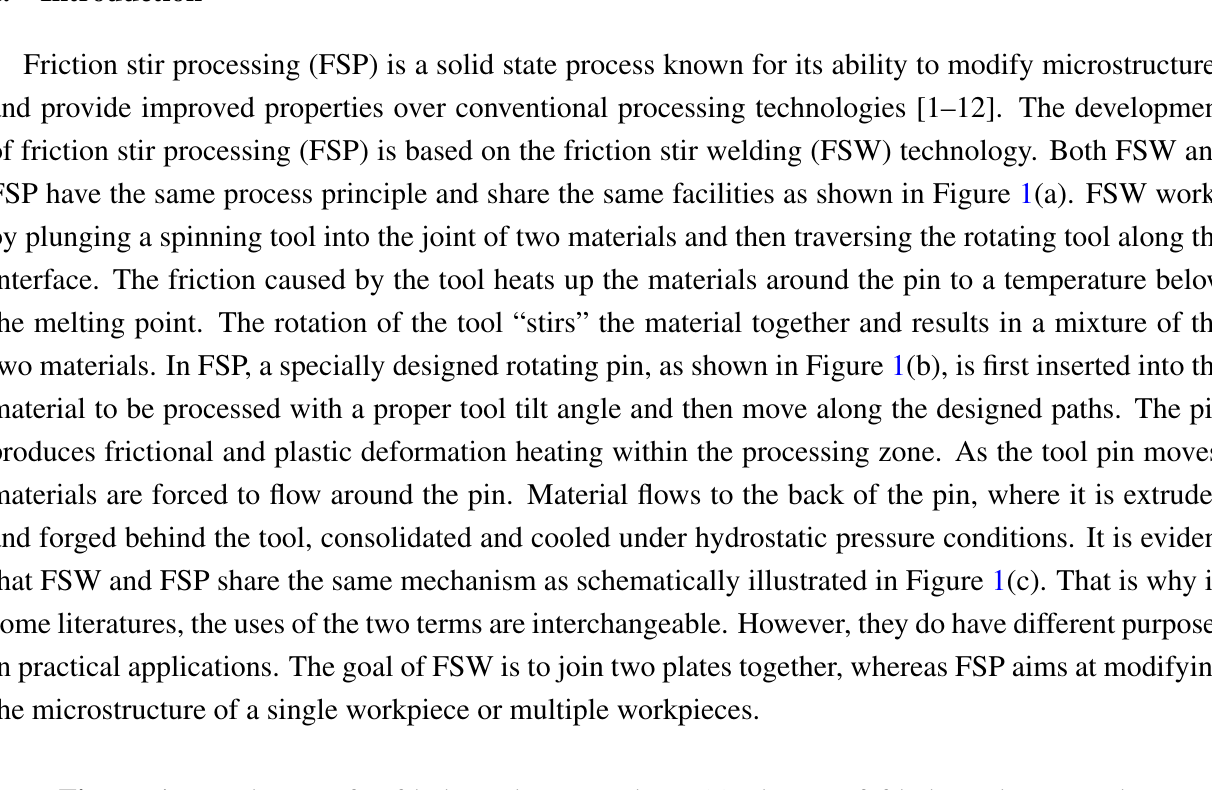
Figure 1 . Equipment for friction stir processing: (a) picture of friction stir processing machine (after Wang et al. [3]); (b) tool pin (after Ceschini et al. [11]); (c) schematic showing the principle of friction stir processing (after Mishra et al.